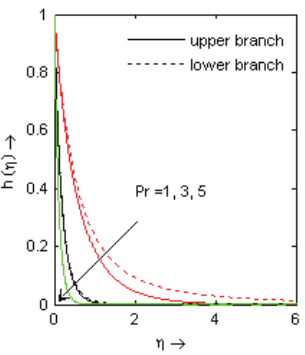
1 , r 2, M 0.5, k 0, Pr D D D (cid:31) D D